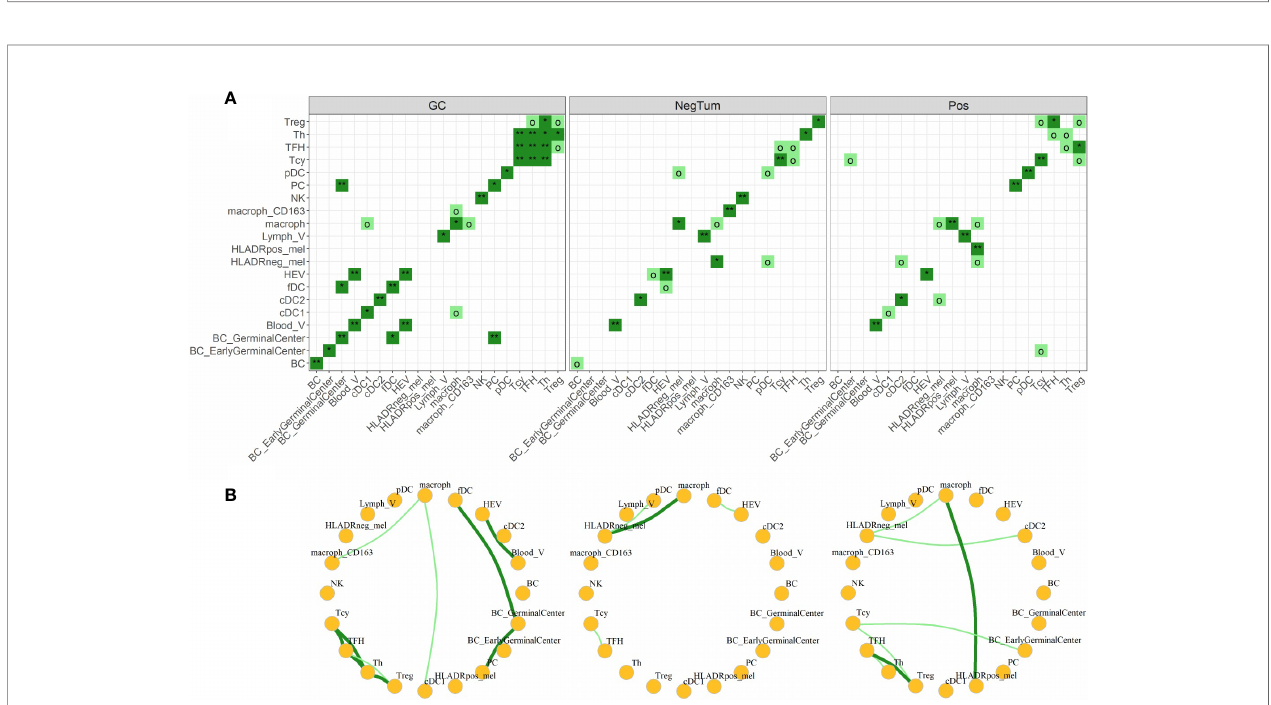
FIGURE 5 | Neighborhood analysis. (A) Heat maps indicating the signi fi cance of cell-cell interactions in the different micro dissected areas. Interactions go from “ strong interaction ” (dark green, p-value < 0.05), “ moderate interaction ” (light green, p-value < 0.1), to “ no interaction ” (white, p-value ≥ 0.1). Signi fi cance levels indicate: o p-value < 0.1, *p-value < 0.05, **p-value < 0.01. (B) Social networks obtained from moderate and strong interactions. Each node in the graph represents a cell-type and each edge an